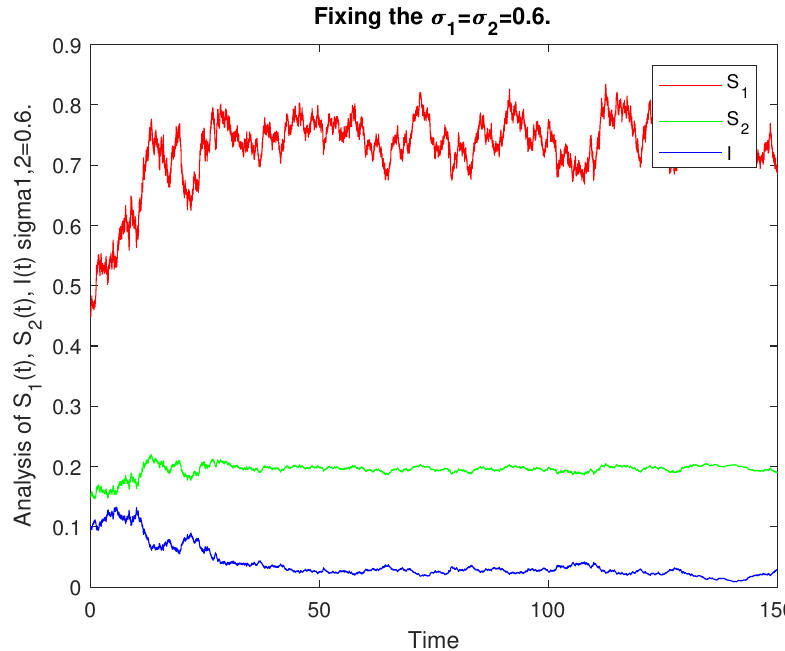
Figure 5. Numerical solution of the model (1) for σ 1 = σ 2 =